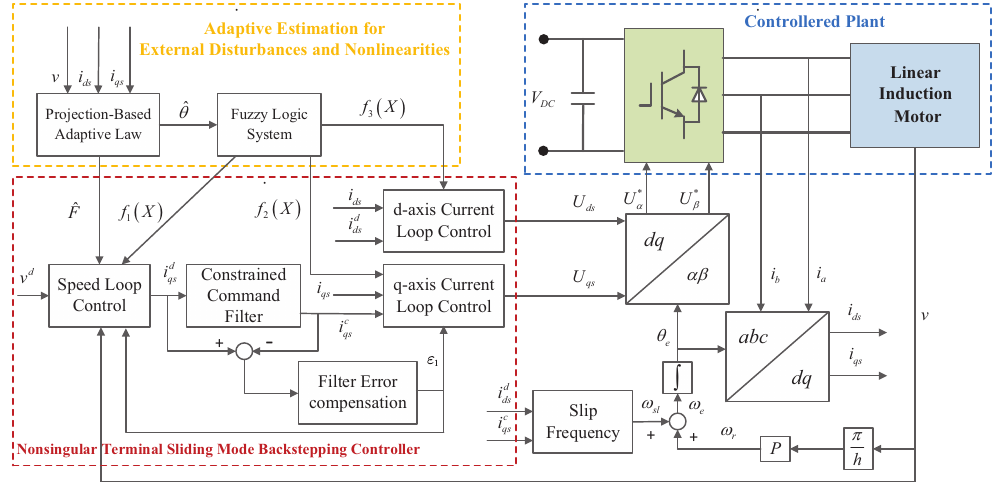
Figure 2. Proposed PACFTB block